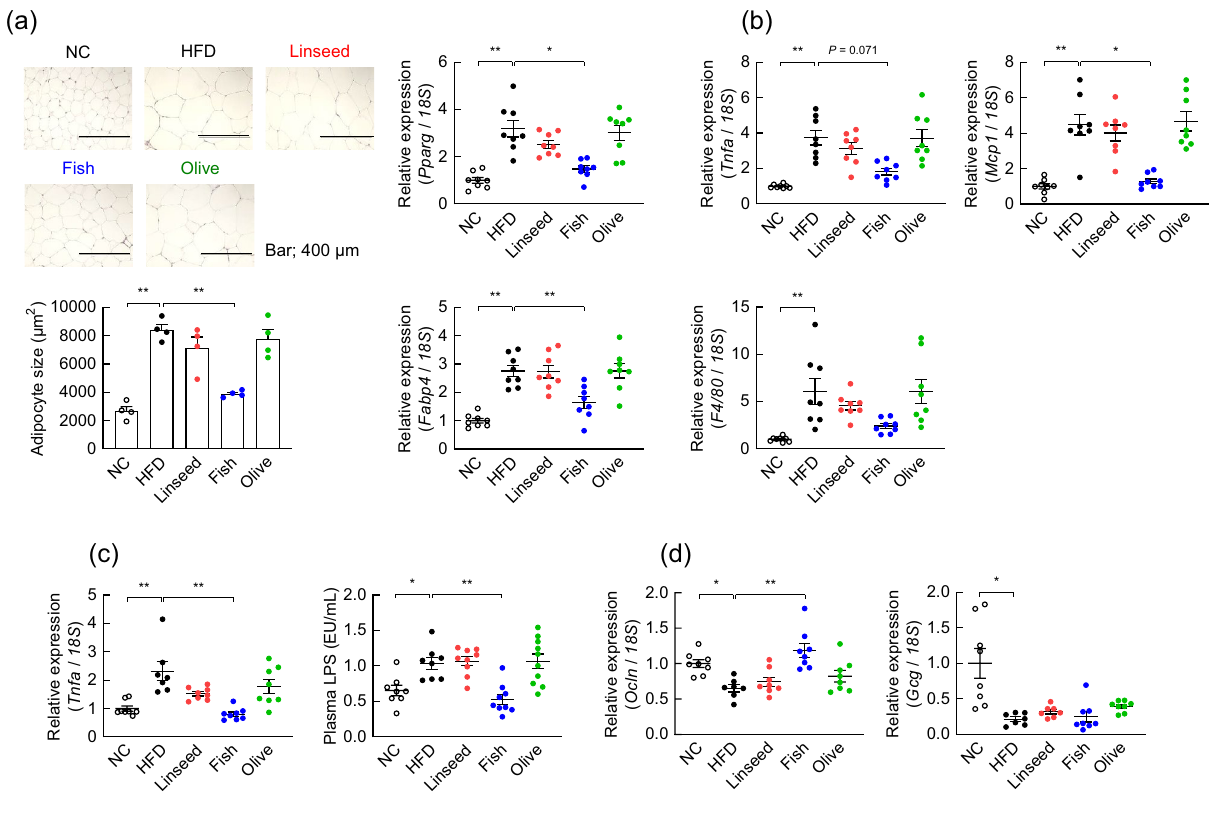
Figure 3. Fish oil suppressed WAT inflammation by enhancing intestinal barrier function. ( a–d ) C57BL/6J male mice were fed either normal chow (NC), a high fat diet (HFD), or a modified HFD diet (Soybean oil in HFD was replaced with either linseed oil (Linseed), fish oil (Fish), or olive oil (Olive)) for 8 weeks. ( a ) Hematoxylin–eosin (H&E)–stained epididymal WAT and the mean area of adipocytes (n = 4 mice for each group). Scale bar; 400 μm. The mRNA expression of Pparg and Fabp4 in the epididymal WAT (n = 8 mice for each group). ** P < 0.01; * P < 0.05 (Tukey–Kramer test for adipocytes size and Fabp4 , and Dunn’s test for Pparg ). ( b ) The mRNA expression of Tnfα , F4/80 , and Mcp-1 in the epididymal WAT (n = 8 mice for each group). ** P < 0.01; * P < 0.05 (Dunn’s test). ( c ) The mRNA expression of Tnfα in the colon ( left panel ) and plasma LPS levels ( right panel ) were measured at the end of the experimental period (n = 7–10 mice for each group). ** P < 0.01; * P < 0.05 (Tukey–Kramer test for plasma LPS and Dunn’s test for Tnfα ). ( d ) The mRNA expression of Ocln , and Gcg in the colon (n = 7–8 mice for each group). ** P < 0.01; * P < 0.05 (Tukey–Kramer test for Ocln and Dunn’s test for Gcg ). Results are presented as means ± standard error.